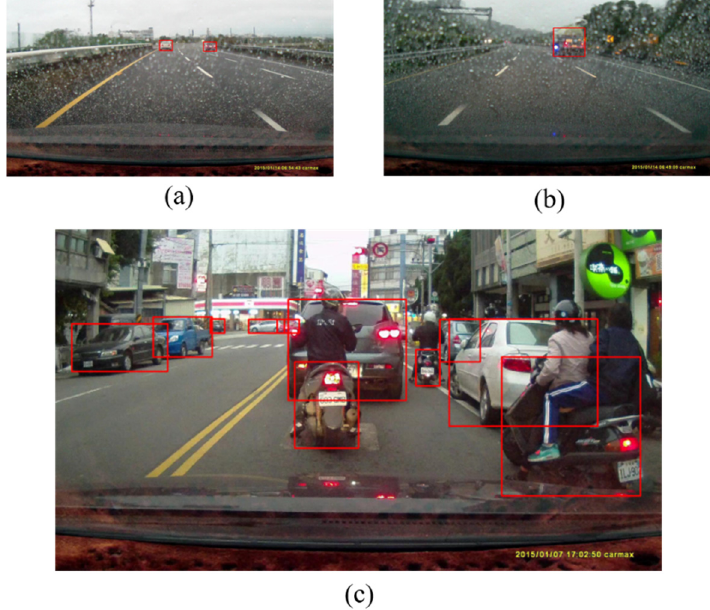
Figure 1. Illustration of the complexity of real driving environments. In real driving environments, objects often appear in different kinds of scale and distance as in ( a – c ).